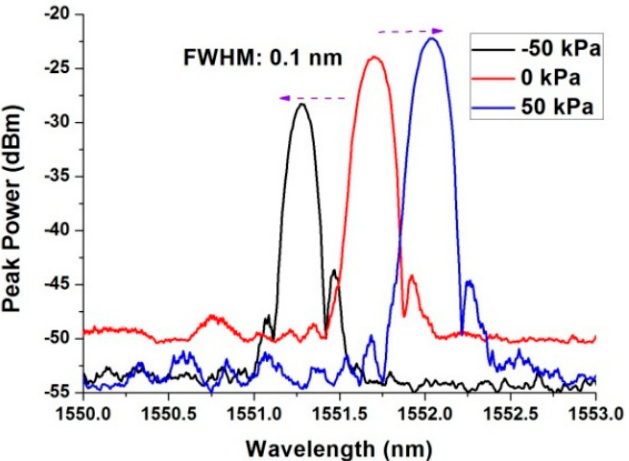
Figure 4. The reflected spectrum of the POF Bragg grating.